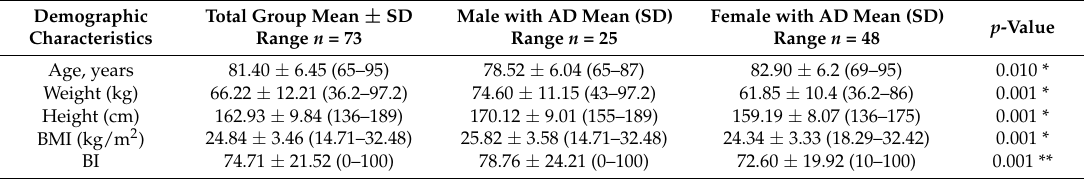
Table 1. Socio-demographic and clinical characteristics of the sample with